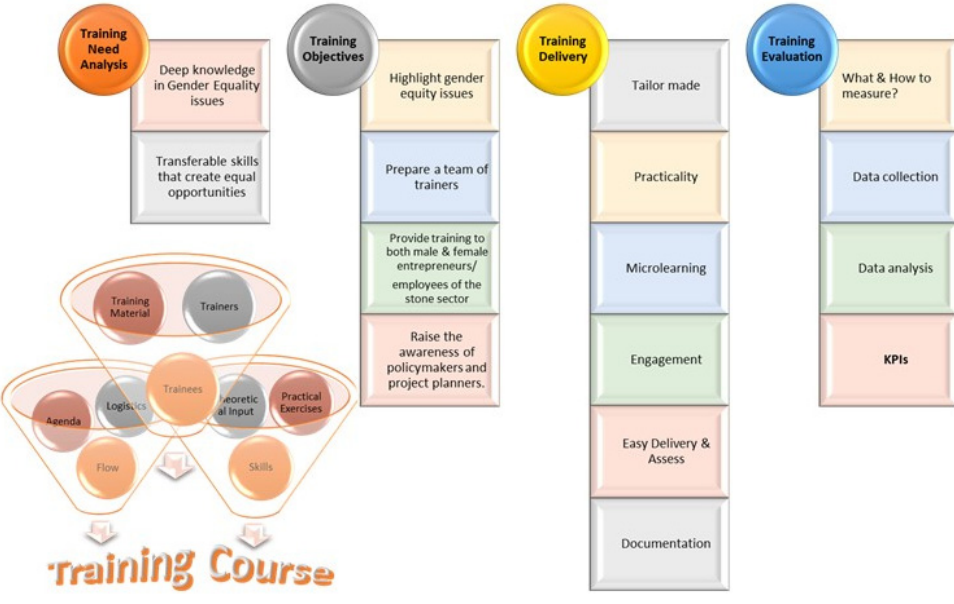
Figure 4. Elements of training design.